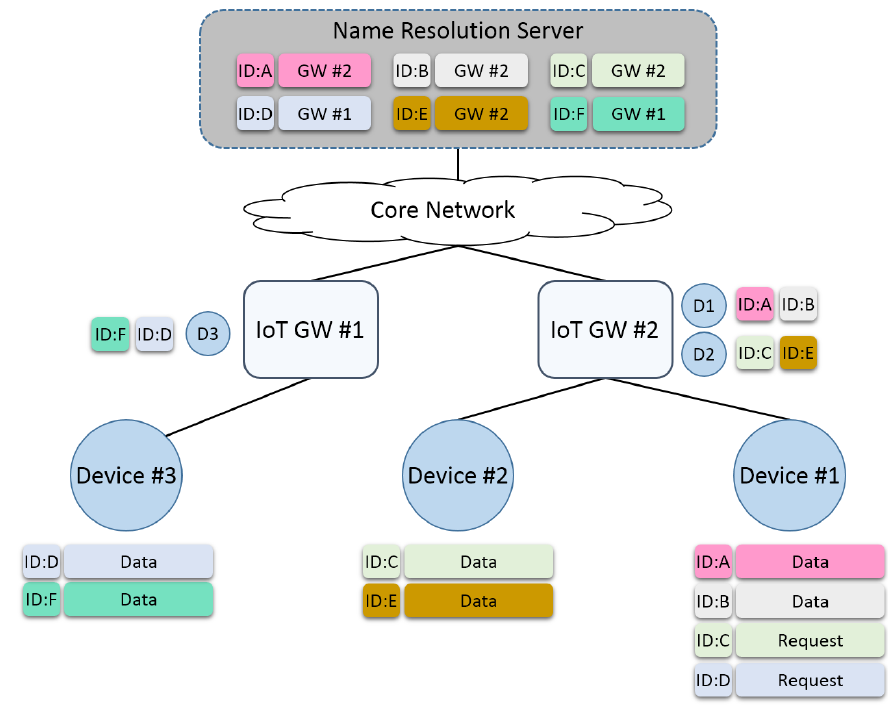
Figure 6. The concept of ID-based